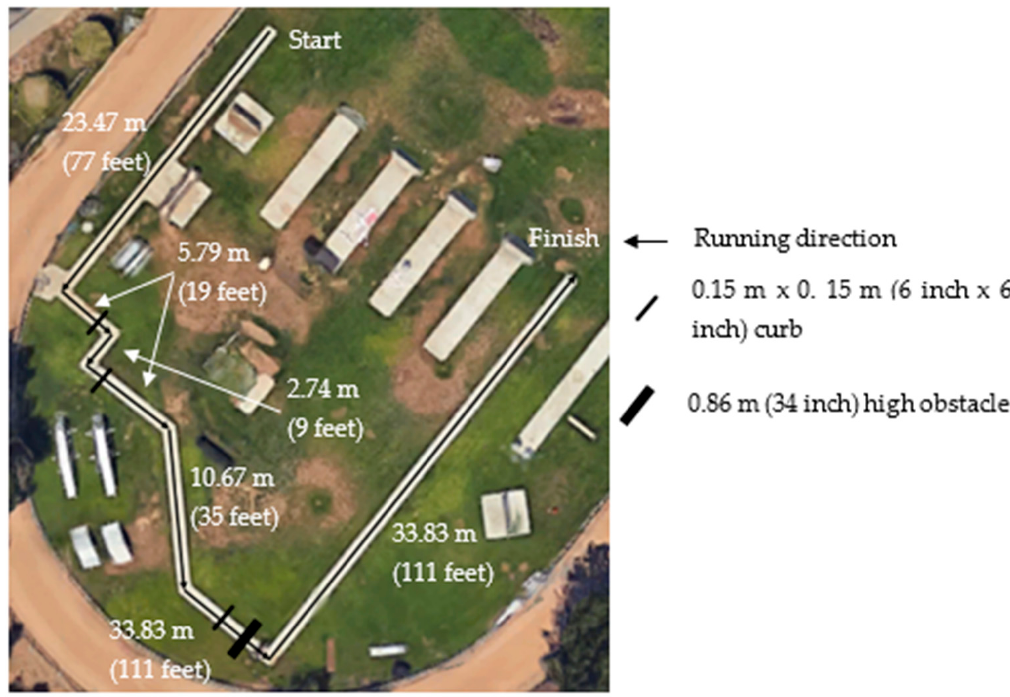
Figure 1. The 99 yard obstacle course.